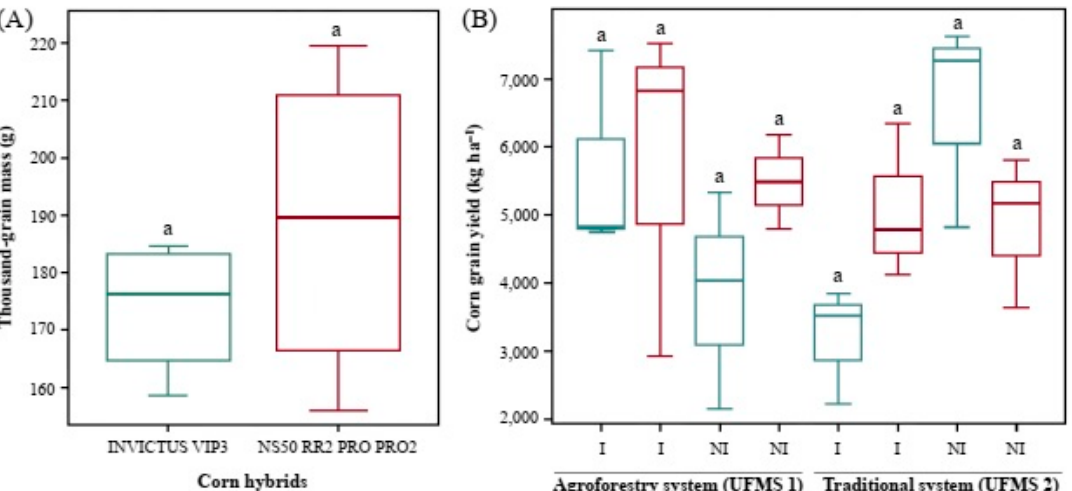
Figure 8. Thousand-grain mass ( A ) and grain yield ( B ) of the two off-season corn hybrids grown in intercropped (I) and nonintercropped (NI) systems with ruzigrass under different production systems [agricultural area with (agroforestry system—UFMS 1) and without (traditional system—UFMS 2) direct effect of the eucalyptus forest] in Chapadão do Sul, MS, Brazil during the 2019 growing season. Green and red boxplots represent corn hybrids INVICTUS VIP3 and NS50 RR2 PRO PRO2, respectively. Bars followed by distinct letters show significant differences by Tukey’s test ( p < 0.05).